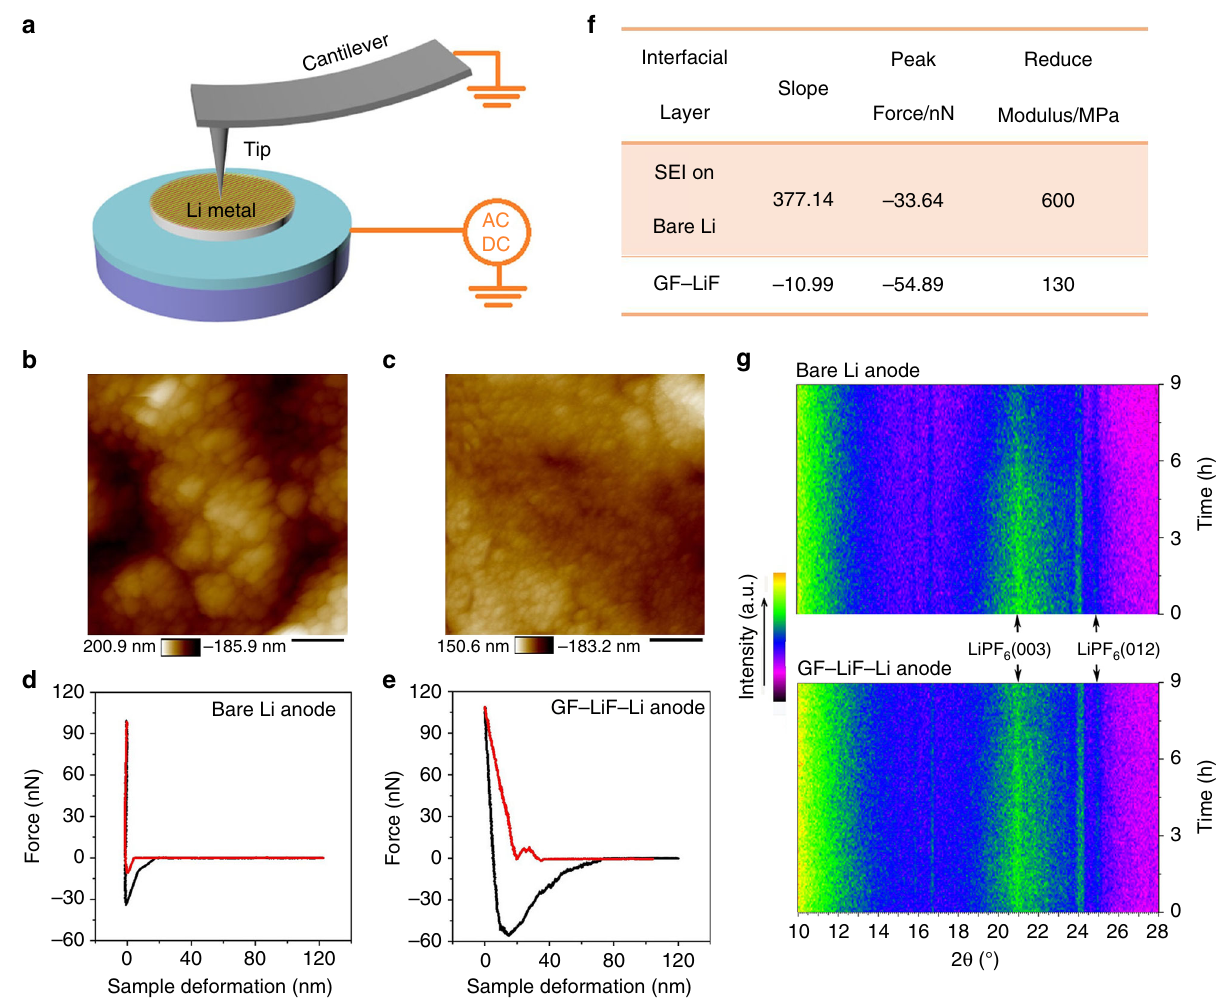
Fig. 4 AFM and in situ XRD measurements. a A schematic diagram for the working principle of AFM. AFM topography images of ( b ) SEI on bare Li foil after the charging – discharging cycle and ( c ) GF – LiF – Li at room temperature. The scale bars are 400 nm. Indentation curves of ( d ) the SEI layer on bare Li and ( e ) GF – LiF layer. f The slope and peak force of loading curves as well as the reduced modulus. g The color plots represented in situ XRD patterns of bare Li anodes (top) and GF – LiF – Li anodes (bottom) upon the fi rst charge – discharge